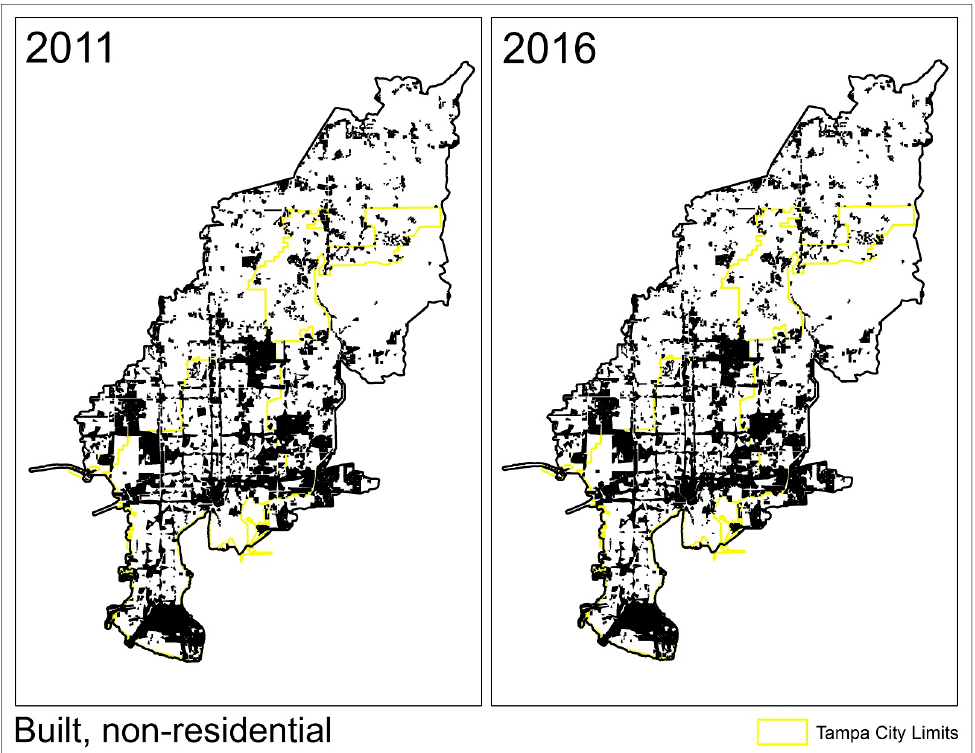
Figure A12. Observed (2011) and Modeled (2016) LULC distribution for the “Built, non-residential” class.